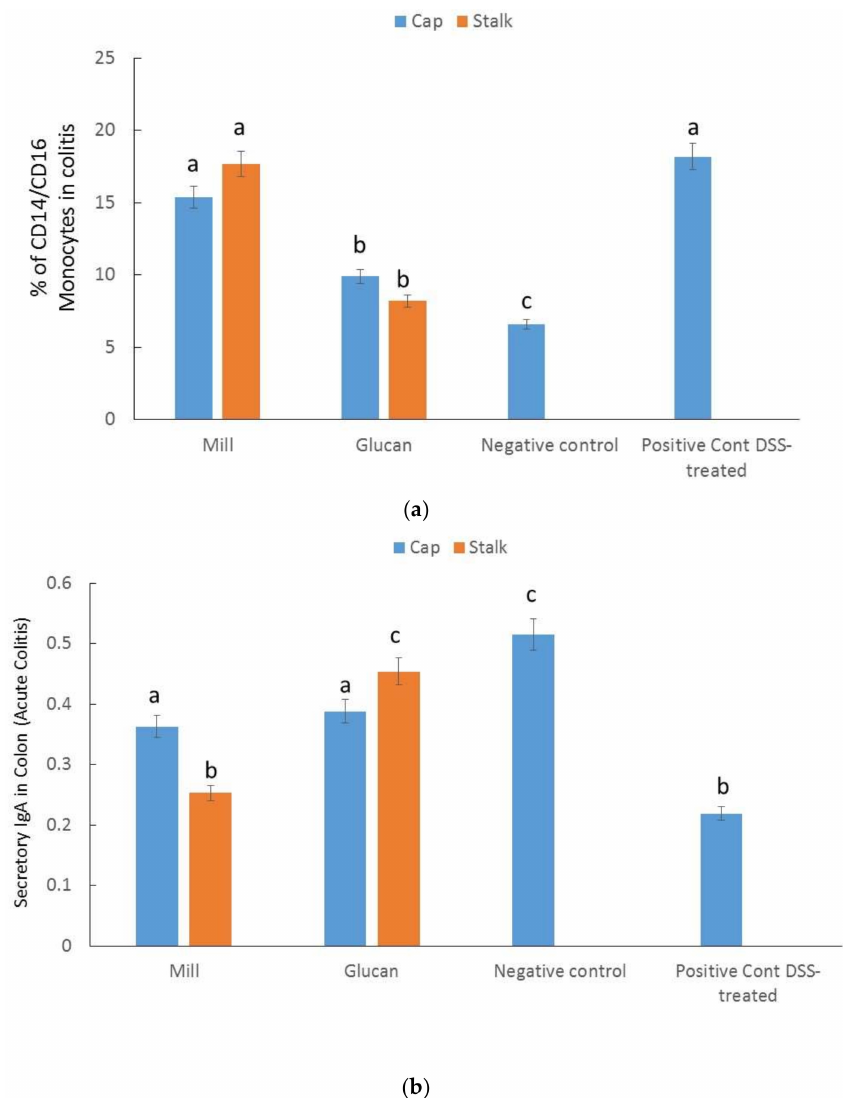
Figure 5. Effect of mill and isolated glucans from caps and stalks of P. eryngii mushrooms (1 mg glucan/kg mice BW) on ( a ) percent of CD14 + /CD16 + monocytes and ( b ) on secretory IgA in feces harvested from mice who underwent DSS-induced colitis. Data represent mean ± SD of six mice per group; data were compared between DSS and mill and isolated glucans from caps and stalks of P. eryngii mushrooms treated groups. Different letters indicate significantly different values at p <